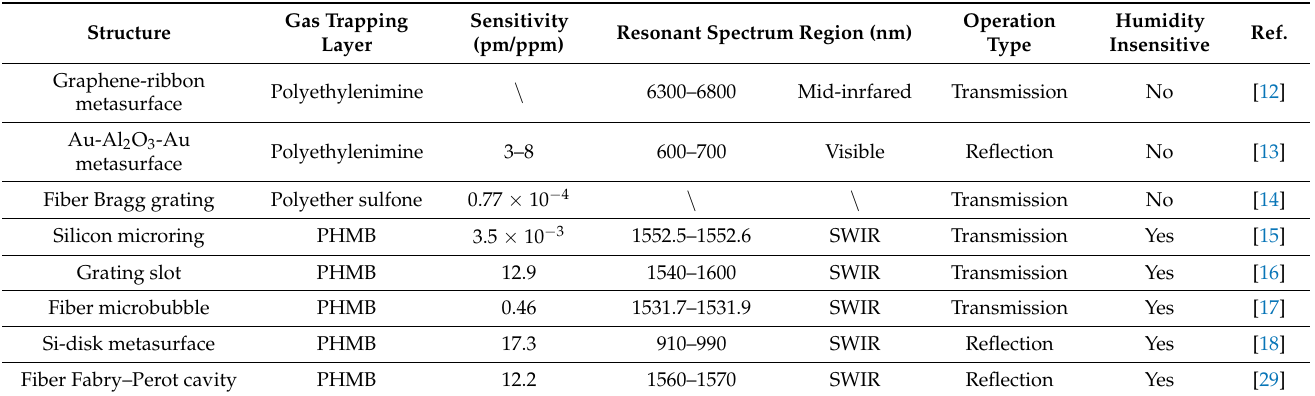
Table 1. Comparison of CO 2 sensing performance between this and previous work based on gas- sensitive polymer materials.